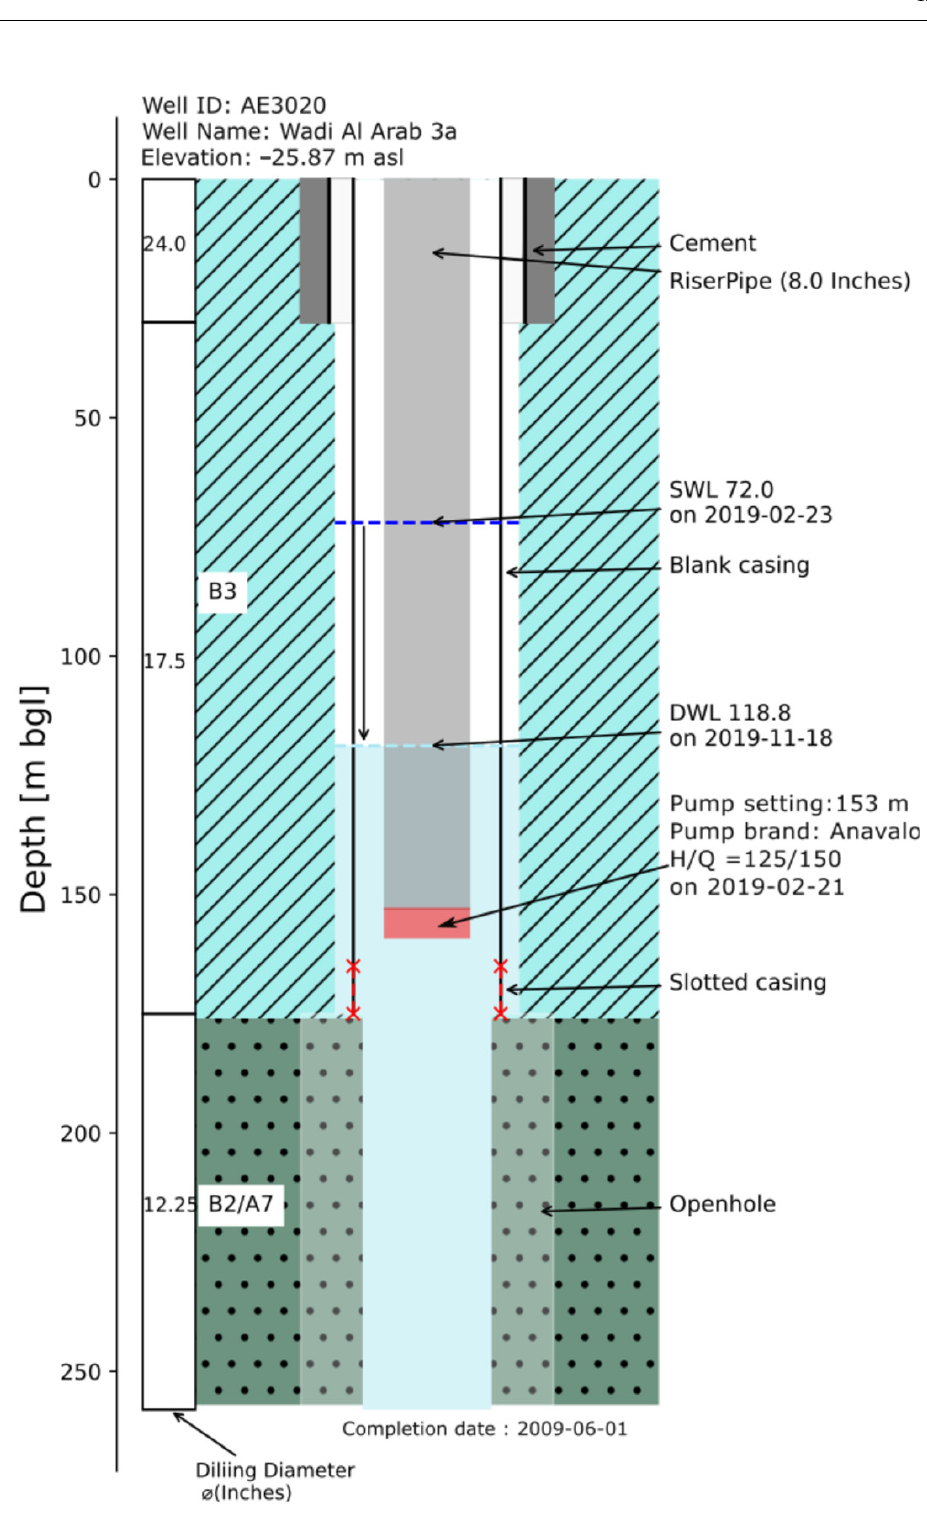
Figure 5. Well status of AE3020 as part of the OBT, a visualization of the recent collected data. Besides, the well’s diary graph gives a general overview of the reasons behind in- terrupting the well’s operation. For instance, in Wadi Al Arab 4, it is clear that the riser pipe (RP) was the reason for stopping the well seven times between 2012 and 2017 (three times because of holes in the pipe, four times for adding extra RP to deepen the pump setting). The graph also provides an overview of the frequency measurements of a par- ticular parameter (SWL, DWL and discharge); this would draw the wellfield manager’s attention if a particular parameter was not collected for a specific well so that actions